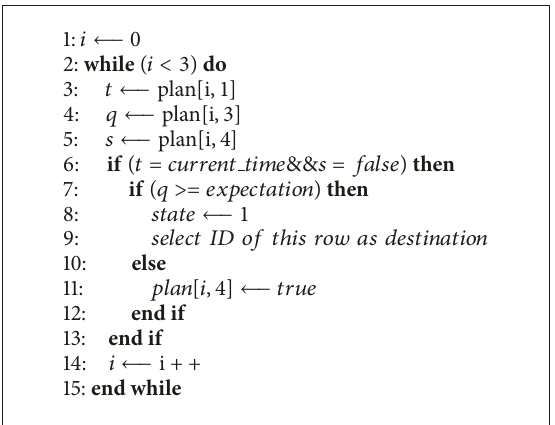
Algorithm 2: Prepare to move to resource (with exclusion)